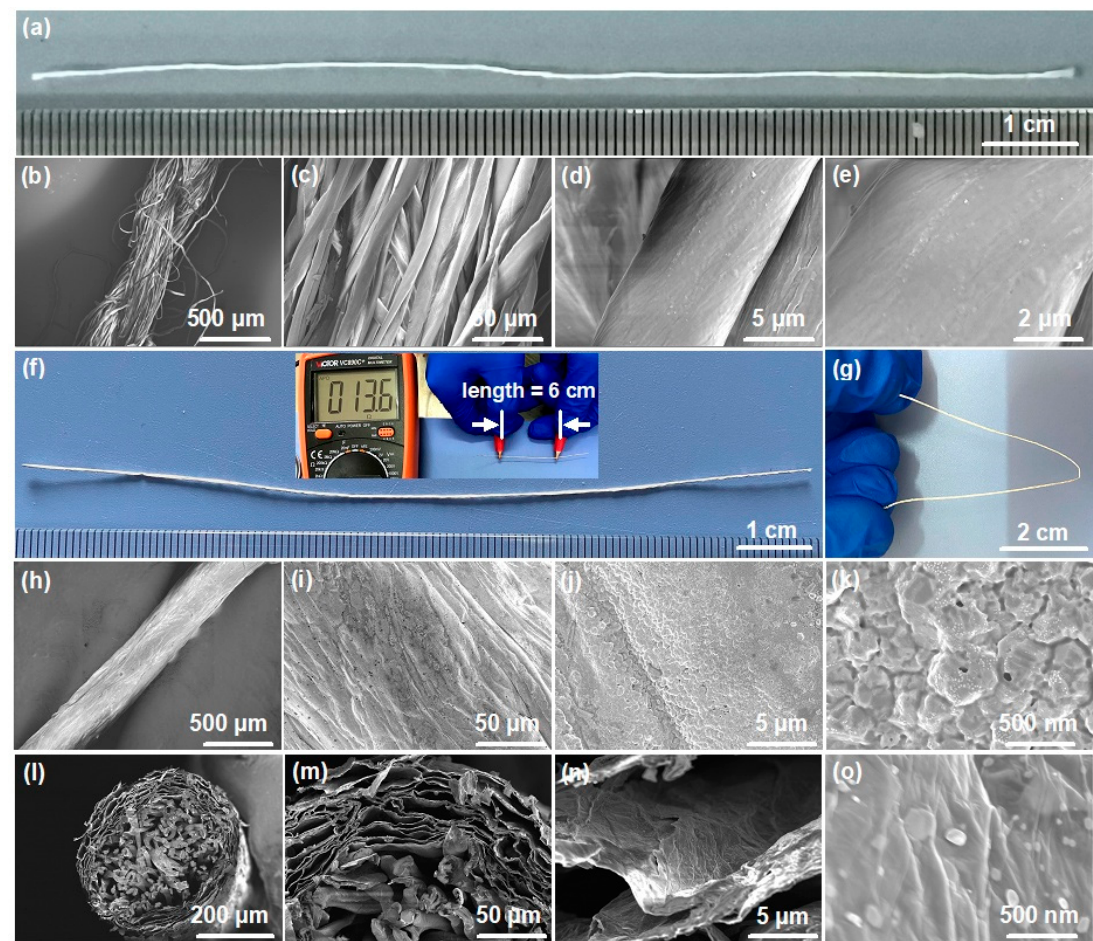
Figure 3. ( a ) Optical photograph of a length of primary cotton yarn; ( b – e ) SEM observations of the pure cotton yarn exhibited in ( a ) at different magnification; ( f – g ) digital images of a length of cotton-RGO-AgNP composite fiber under natural and bent conditions, respectively; the inset of ( f ) shows the measurement of its electrical resistance using a multimeter; ( h – k ) top-view SEM inspections of cotton-RGO-AgNP fiber from low to high magnification, displaying morphological details of its outer surface; ( l – o ) cross-sectional SEM examinations of cotton-RGO-AgNP fiber, which disclose a typical core–shell structure with cotton yarn as core and porous RGO/AgNP composite film as shell.